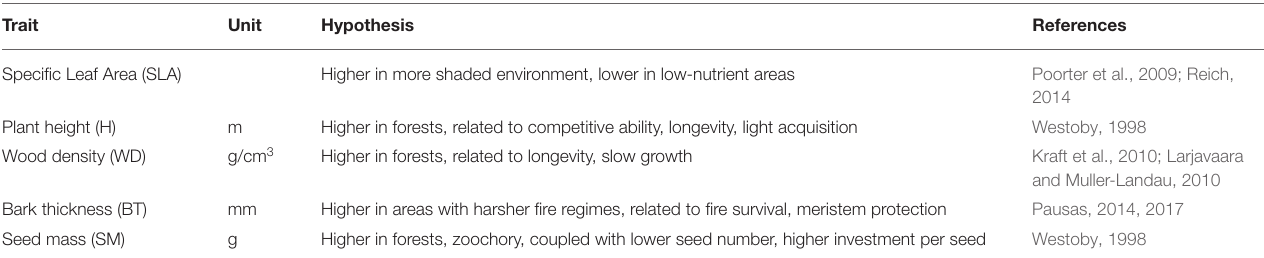
TABLE 2 | Functional response traits measured for this study, their units, and hypotheses related to fire resistance and forest growth.